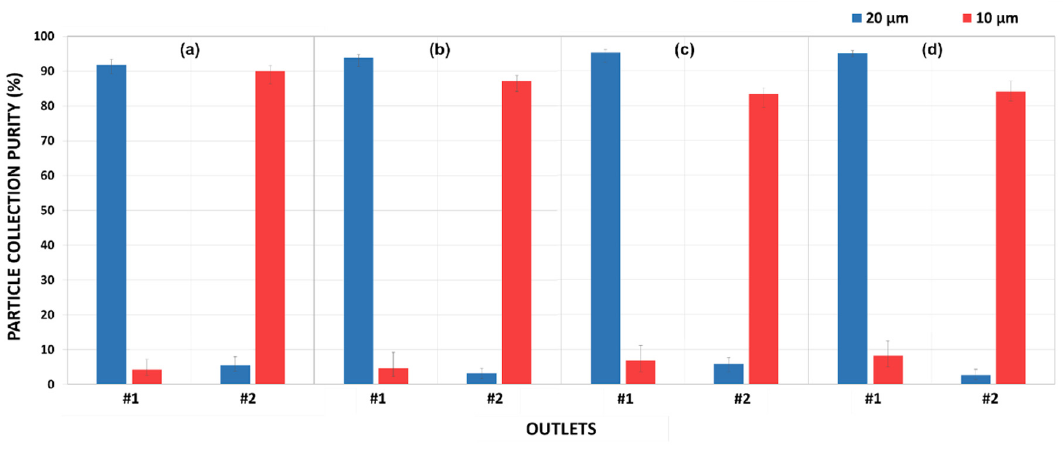
Figure 8. The particle separation purities obtained from the ratio of collected particles at particular outlets to the total collected particles for outlets #1 and #2 in Case 1 ( a ), Case 2 ( b ), Case 3 ( c ), and Case 4 ( d ).